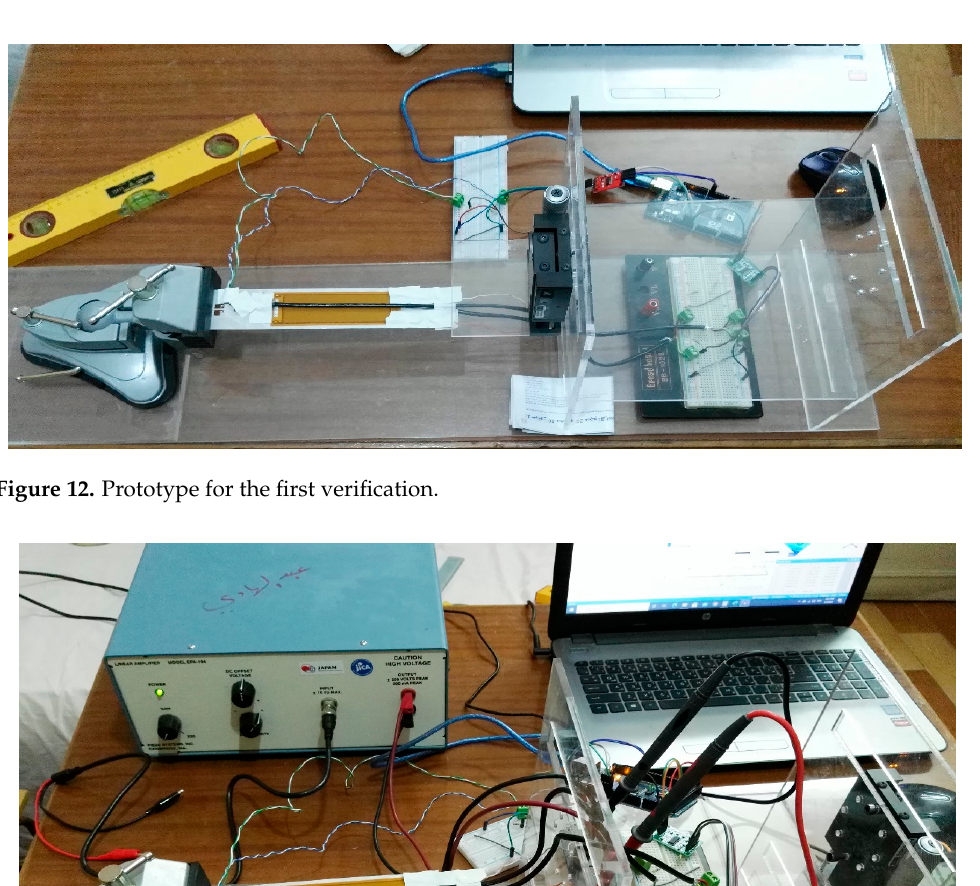
( b ) Figure 11. ( a ) Boost converter circuit; ( b ) MATLAB-Simscape model for the boost converter. The relationship between input and output voltage of the boost converter can be de- scribed by the following equation: V (cid:2925)(cid:2931)(cid:2930) = V (cid:2919)(cid:2924) 1 − D (32) where D is the duty cycle set to about 50% in the experiment, V (cid:2919)(cid:2924) is the input voltage to the boost converter, which was supplied from the EPA-104 with 200 V, and V (cid:2925)(cid:2931)(cid:2930) is the output voltage from the boost converter supplied to the MFC actuator.